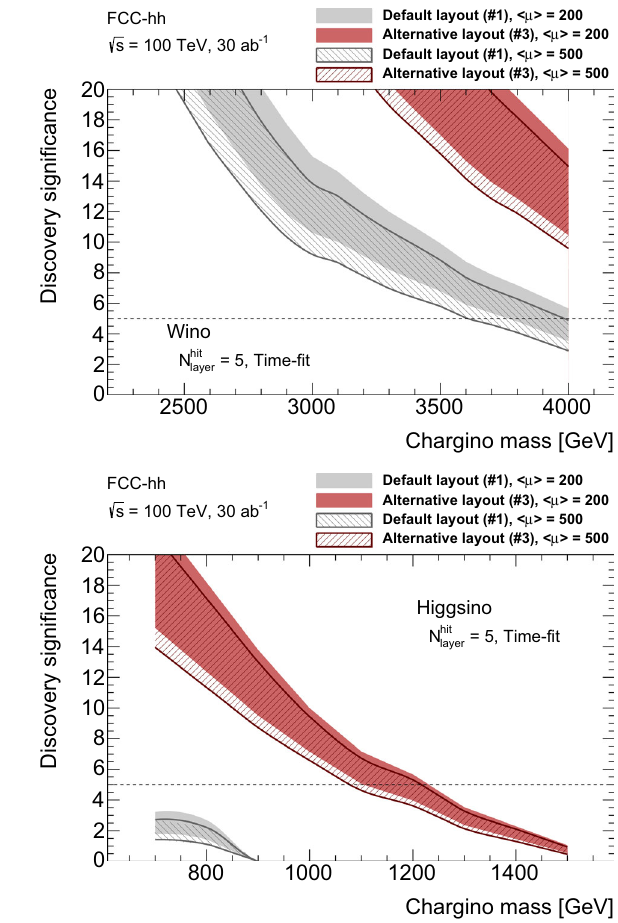
Fig. 6 Expecteddiscoverysignificanceforthewino(top)andhiggsino = 5. The (bottom) models with 30 ab − 1 with the requirements of N hit layer a good time-fit quality. The background reduction rate with the time information is assumed to be the same for both pileup conditions. The grey (red) bands show the significance using the default (alternative) layout #1 (#3). The difference between the solid and hatched bands corresponds to the different pileup conditions of (cid:8) μ (cid:9) = 200 and 500. The band width corresponds to the significance variation due to the two models assumed for soft QCD